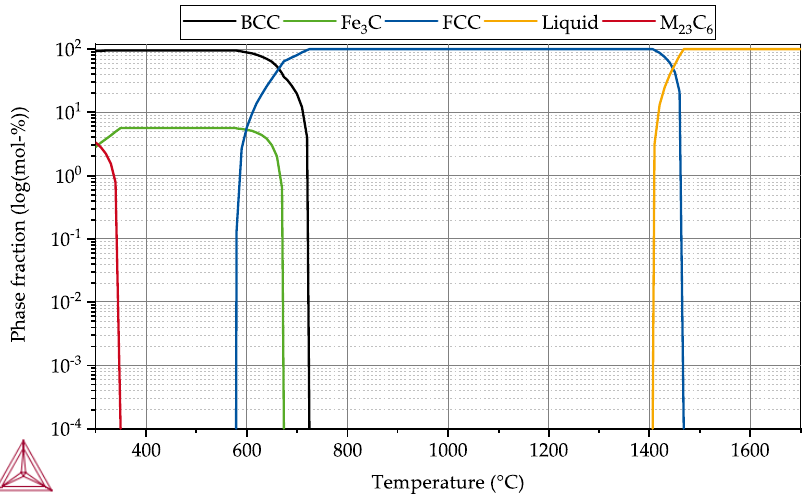
Figure 3. Thermocalc simulation of most stable phases for